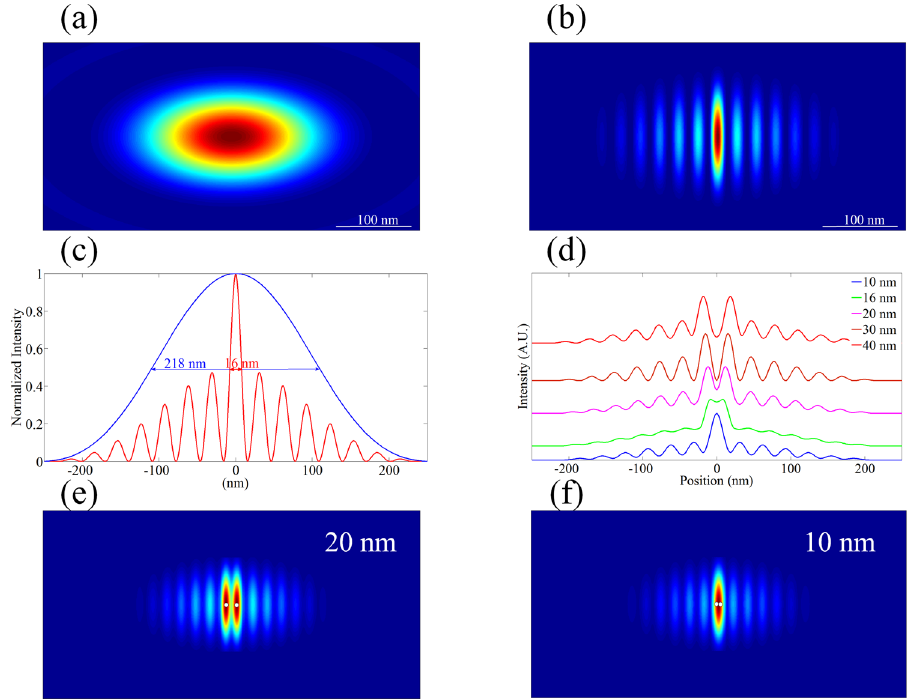
Figure 6. The simulation results of the MSS imaging performance. Point spread function of ( a ) a diffraction- limited system, ( b ) reconstructed image in x -direction, ( c ) FWHM comparison between conventional epi- fluorescence microscopic image (blue curve) and the super-resolution image by using the MSS (red line) in PSIM. ( d ) Illustration of resolving capability of MSS-PSIM of two PEs with size of 10 nm and separated with different distances of 10, 16, 20, 30 and 40 nm in x -direction. ( e ) The reconstructed image of two PEs separated by 20 nm. ( f ) The reconstructed image of two PEs separated by 10 nm. The white circles denote the positions and distributions of